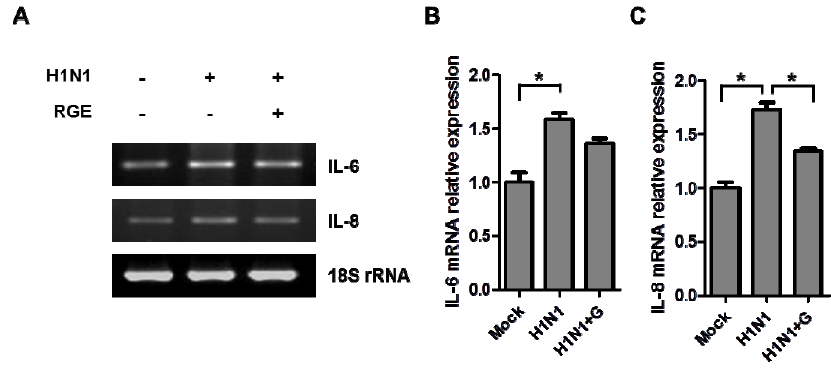
Figure 3. Influence of RGE on H1N1 influenza A virus-induced cytokine production in A549 cells. ( A ) Representative RT-PCR bands of cytokine mRNA expression. ( B and C ) The relative quantity of cytokine mRNA expression. A549 cells were mock-infected or infected with H1N1 influenza A virus. A549 cells were continuously treated with RGE (250 μ g/mL) starting with 24 h pre-incubation period. After virus infection, cells were treated with or without RGE for another 48 h. Cytokine mRNA levels were determined by semiquantitative RT-PCR. Values are the mean ± SEM. * p <